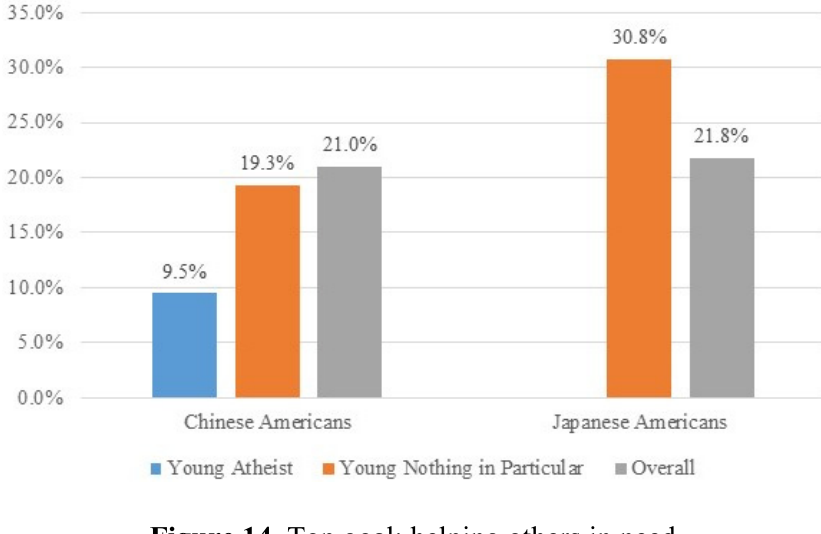
Figure 14. Top goal: helping others in need.